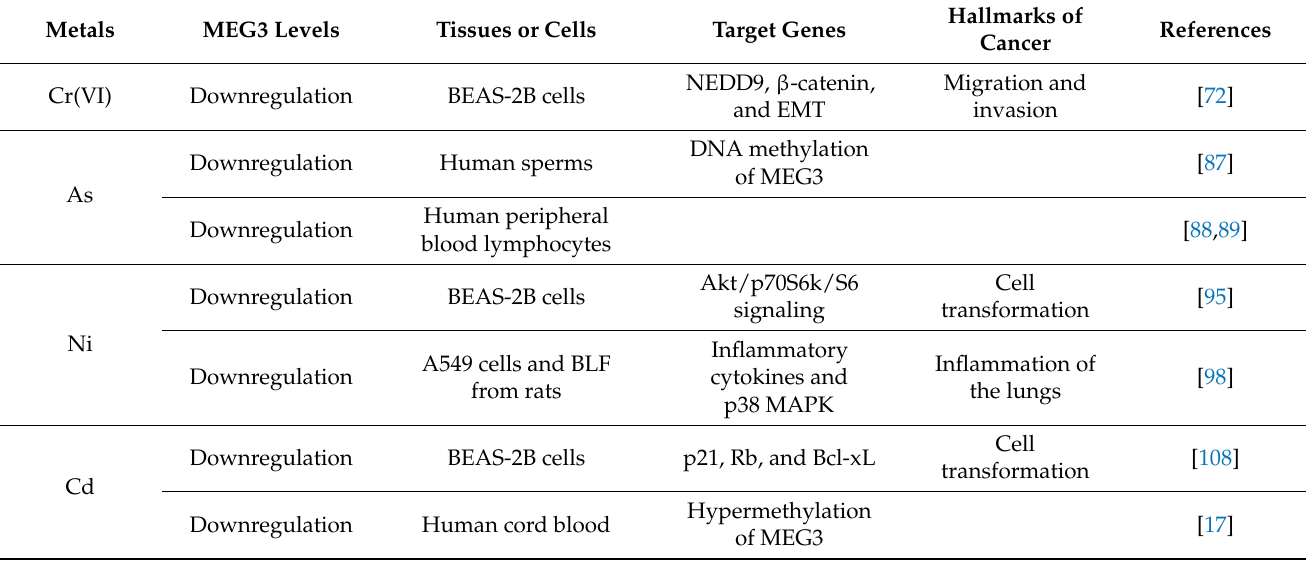
Table 2. The role of MEG3 in metal-induced carcinogenesis. Exposure to chromium (Cr(VI)), arsenic (As), nickel (Ni), or cadmium (Cd) downregulated MEG3, disrupting multiple cellular signaling pathways, leading to malignant cell transformation, inflammation, and enhanced migration and invasion. BEAS-2B: human bronchial epithelial cells. BLF: bronchoalveolar lavage fluid. Tissues or